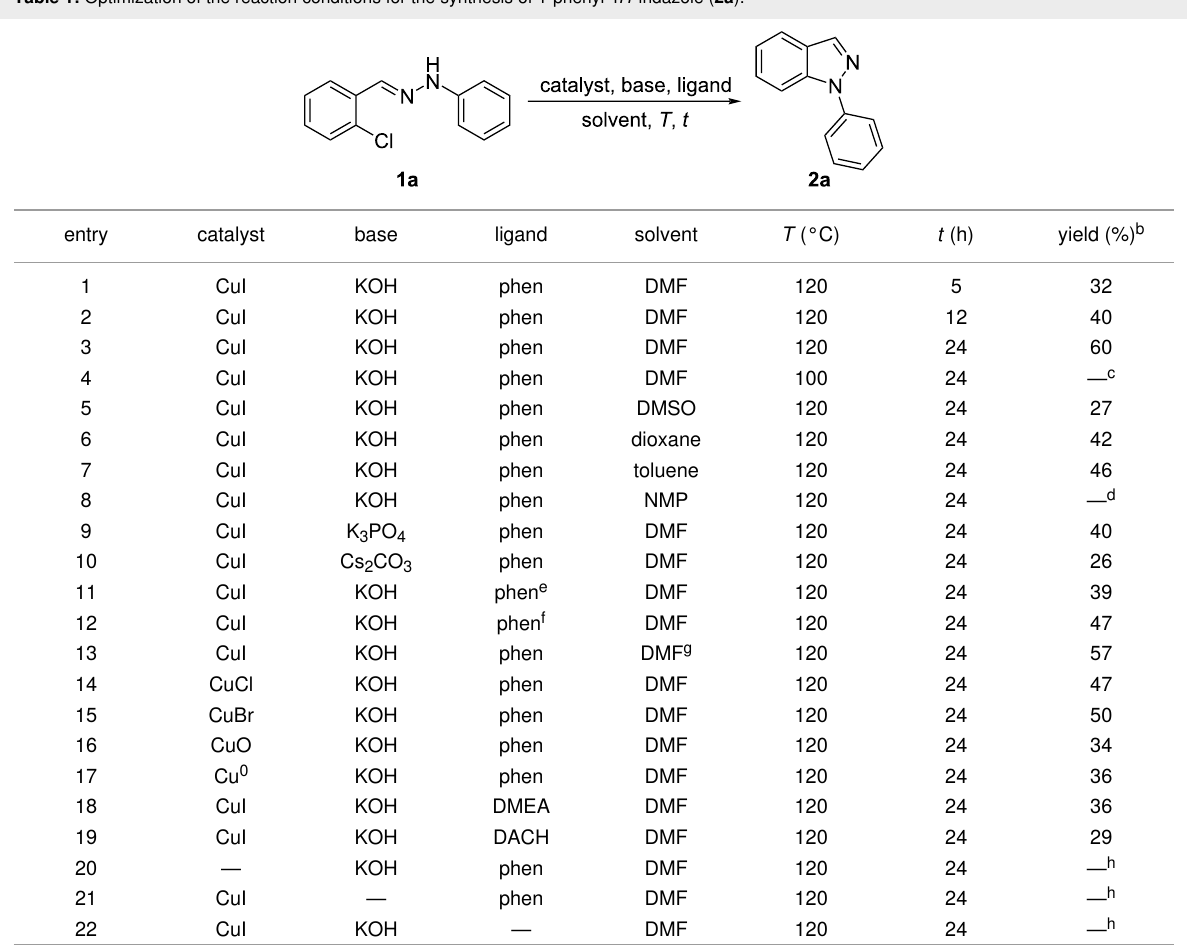
Table 1: Optimization of the reaction conditions for the synthesis of 1-phenyl-1 H -indazole ( 2a ).